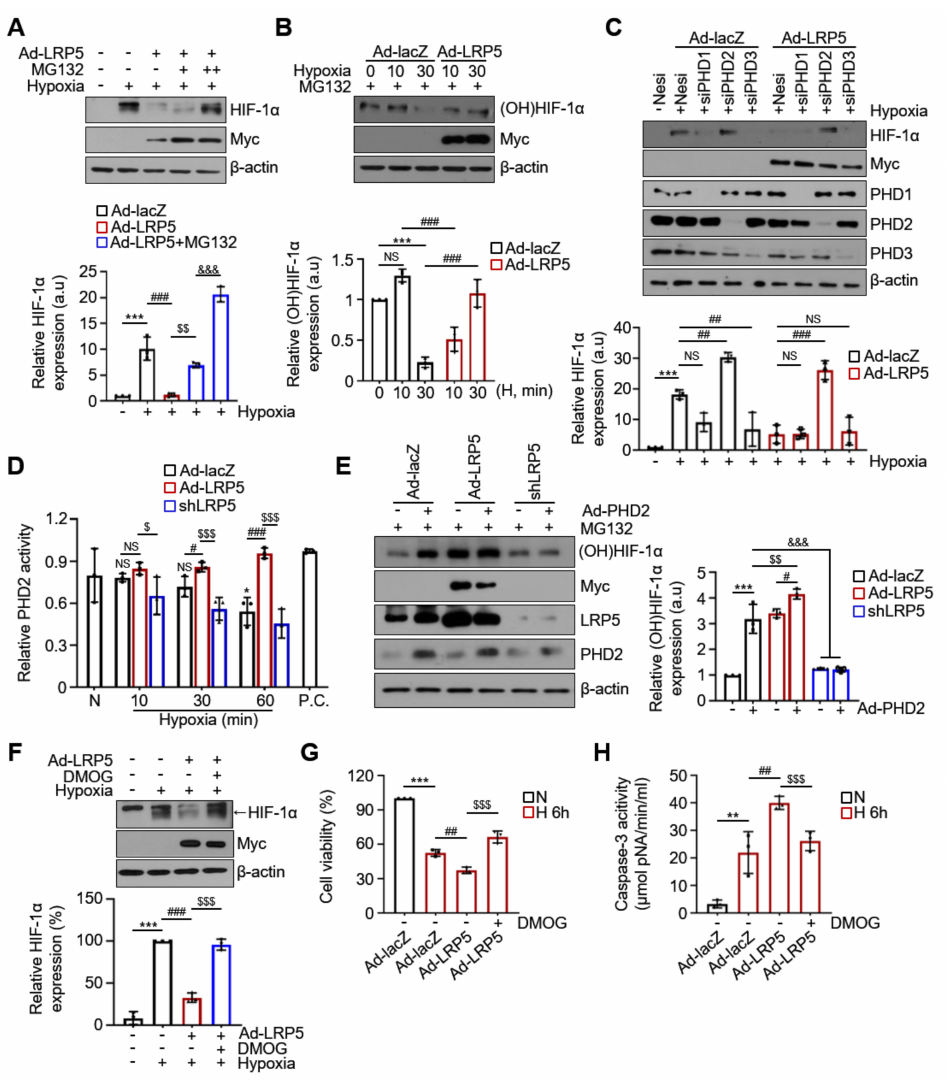
Figure 4. LRP5 regulates the hydroxylation of HIF-1 α mediated by PHD2. ( A ) Representative western blots showing the effect of MG132 on the expression of HIF-1 α in Ad-lacZ- or Ad-LRP5-infected cardiomyocytes. Cardiomyocytes were infected with the indicated adenoviruses for 48 h and treated with 1 and 10 µ M MG132 for 6 h before exposure to hypoxic conditions. n = 4/group. Means ± SD. *** p < 0.001 versus Normoxia; ### p < 0.001 Ad-LRP5 versus Ad-lacZ; $$ p < 0.01 Ad-LRP5+MG132 (1 µ M) versus Ad-LRP5 alone; &&& p < 0.001 Ad-LRP5+MG132 (10 µ M) versus Ad-LRP5+MG132 (1 µ M). ( B ) Determination of hydroxylated HIF-1 α levels using a specific antibody recognizing Pro564-HIF-1 α . Cardiomyocytes were infected with the indicated adenoviruses for 48 h and treated with 10 µ M MG132 for 6 h before exposure to hypoxic conditions. n = 4/group. Means ± SD. *** p < 0.001 versus Normoxia; ### p < 0.001 Ad-LRP5 versus Ad-lacZ; $$$ p < 0.001 Ad-LRP5 versus Ad-lacZ; NS, no significance. ( C ) Representative western blot analysis showing HIF-1 α protein levels. Cardiomyocytes were transiently transfected with either negative siRNA (Nesi) or PHD1-3-specific siRNAs; 24 h after transfection, cells were infected with Ad-lacZ or Ad-LRP5 for 48 h and then exposed to hypoxia for 90 min. n = 4/group. Means ± SD. *** p < 0.001 versus Normoxia; ## p < 0.01, ### p < 0.001 siPHDs-transfected versus Nesi; NS, no significance. ( D ) PHD2 activity was evaluated using a biotinylated HIF-1 α oxygen-dependent degradation domain and hydroxylated control peptide (P.C.). n = 3/group. Means ± SD. * p < 0.05 versus Normoxia; # p < 0.05, ### p < 0.001 Ad-LRP5 versus Ad-lacZ; $ p < 0.05, $$$ p < 0.001 shLRP5 versus Ad-LRP5; NS, no significance. ( E ) Representative western blots showing the effect of PHD2 expression on the expression of hydroxylated HIF-1 α in Ad-lacZ-, Ad-LRP5-, and shLRP5-infected cardiomyocytes under hypoxic conditions (30 min). All groups were treated with 10 µ M MG132 for 6 h before exposure to hypoxic conditions. n = 3/group. Means ± SD. *** p < 0.001 Ad-PHD2 versus control; # p < 0.05 Ad-LRP5+Ad-PHD2 versus Ad-LRP5 alone; $$ p < 0.01 Ad-LRP5+Ad-PHD2 versus Ad-lacZ+Ad-PHD2; &&& p < 0.001 shLRP5 versus Ad-lacZ or Ad-LRP5 w/ or w/o Ad-PHD2. ( F ) Representative western blots showing the effect of DMOG on